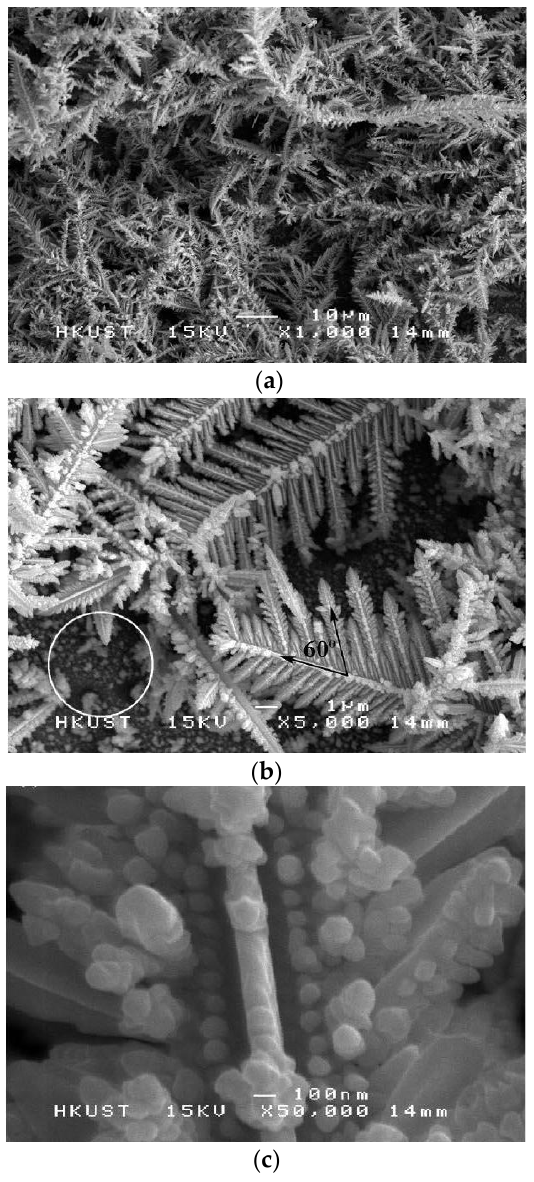
Figure 6. SEM images of the dendritic Ag structure. ( a ) Low magnification; ( b ) medium magnification; ( c ) high magnification. Reprinted (adapted) with permission from [68]. Copyright 2008, American Chemical Society.